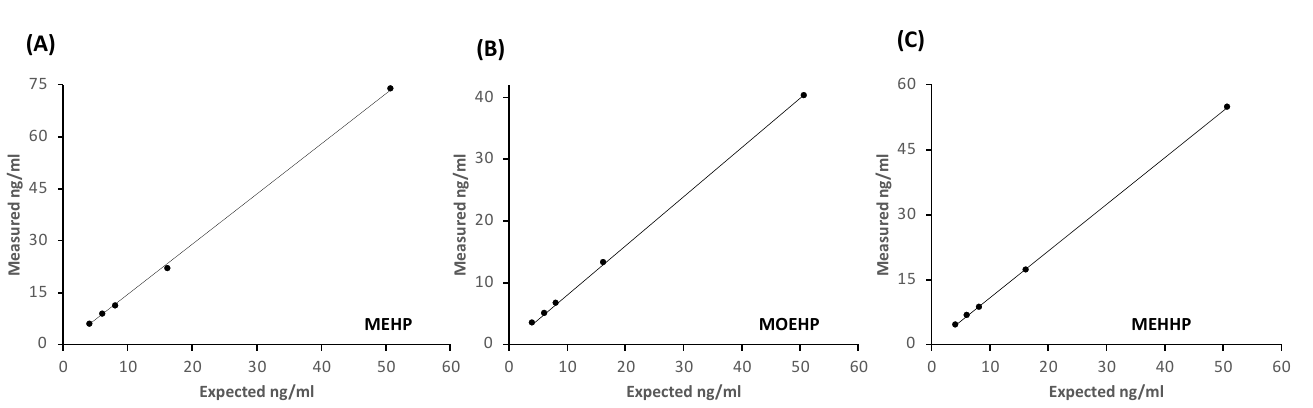
Figure A1. Standard curves of DEHP metabolites measured by UHPLC/MS-QTOF: ( A ) MEHP ( B ) MEOHP ( C ) MEHHP. Measured concentrations expressed as ng/mL (N = 29) of DEHP metabolites are reported in the y axis while expected (theoretical) values are shown in the x axis; R = 0.99 for all metabolites.